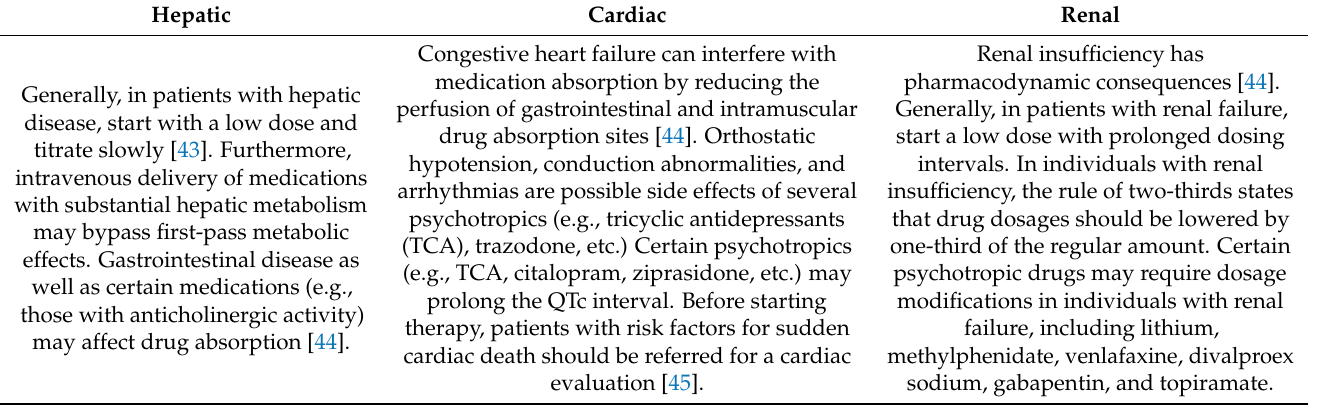
Table 4. Additional considerations when selecting an